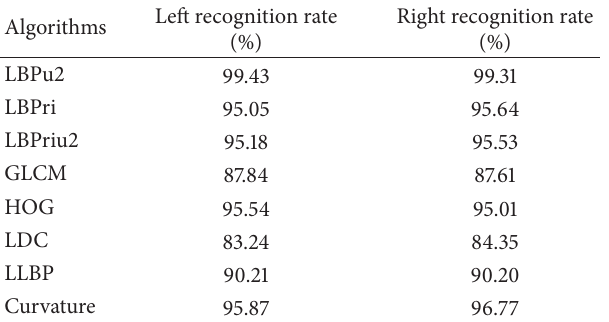
Table 6: Recognition results with comparison of algorithm.